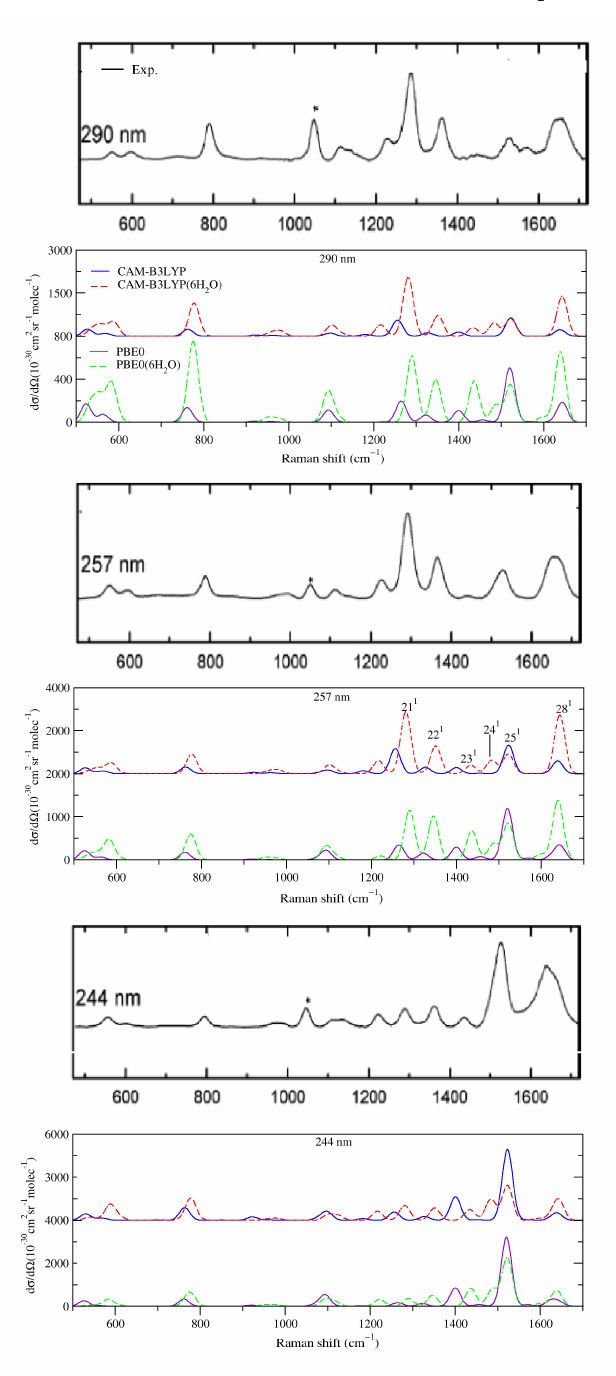
Figure 4. Vibrational Resonance Raman spectra, computed by VG Int , for cytosine in water (PCM) and the cluster cytosine ¨ 6H 2 O in the PCM, convoluted with a Lorentzian with damping, γ = 0.04 eV, and a Gaussian with HWHM = 0.12 eV, calculated by CAM-B3LYP and PBE0 and 6-311G+(d,p) basis set. The black, thick panels report the experimental data in aqueous solutions; reprinted with permission of [35]. Copyright 2007 American Chemical Society. The experimental band marked with an asterisk is attributed to the internal